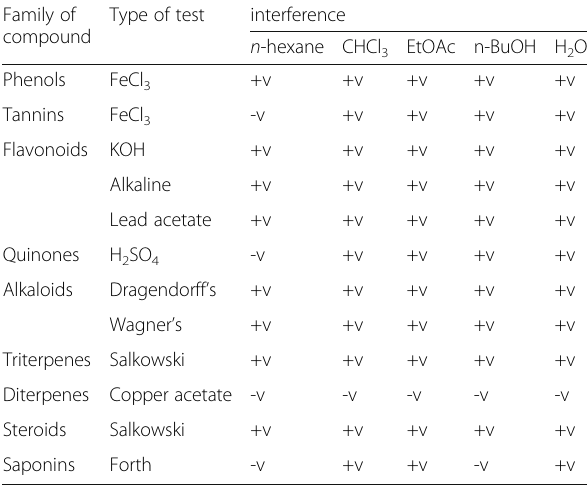
Table 1 Preliminary screening of secondary metabolites in the fractions of S. latifolius